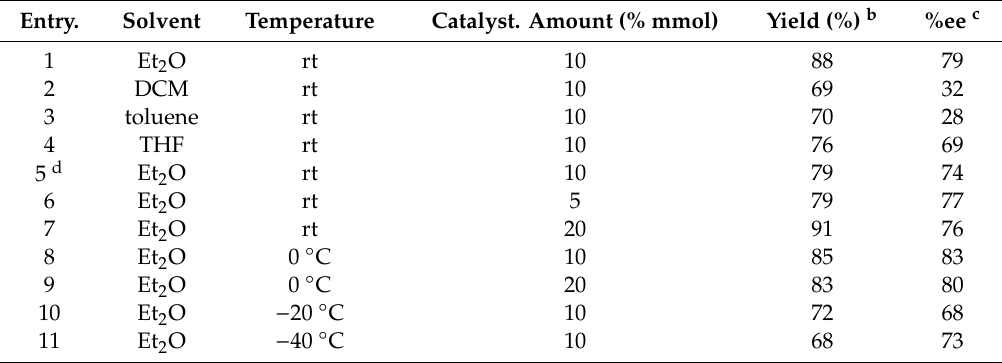
Table 2. Screening of the reaction conditions for the asymmetric hydroxyalkylation a . Entry. Solvent Temperature Catalyst. Amount (% mmol) Yield (%)